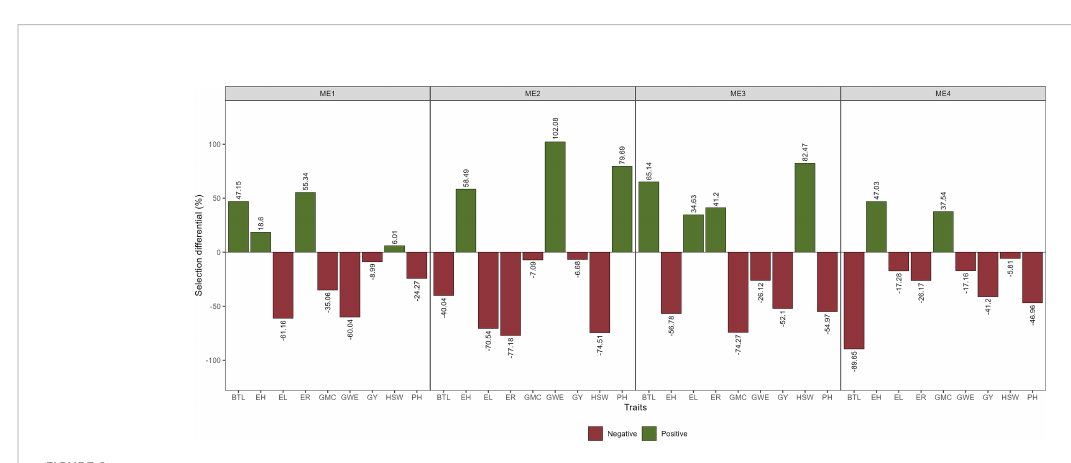
FIGURE 9 Selection gains for stability considering the selection within each